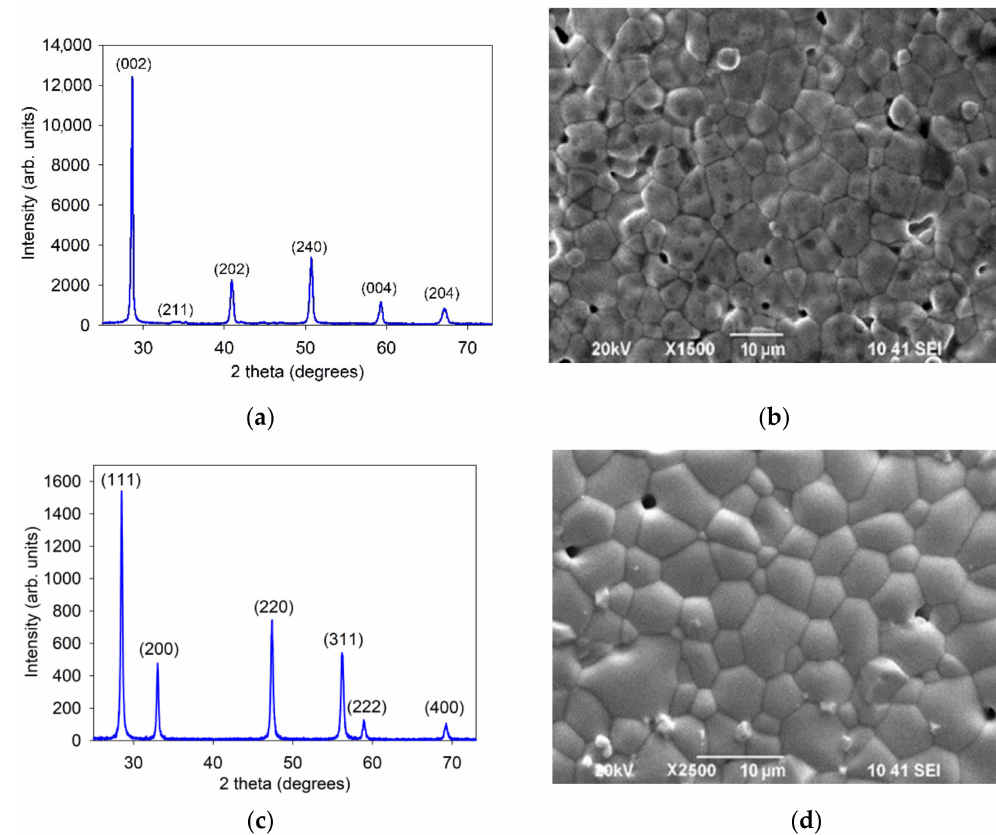
Figure 1. Characterization of the BCSCuO and SDC electrolytes: ( a , c ) XRD patterns of the BCSCuO and SDC powders; ( b , d ) Surface SEM images of the BCSCuO and SDC compact samples sintered at 1450 ◦ C for 5 h and at 1600 ◦ C for 3 h,